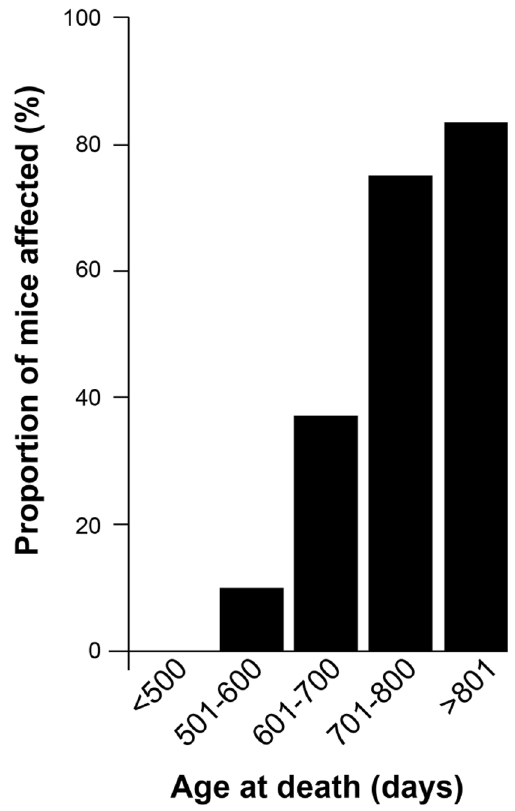
Figure 3. Age dependence of spontaneous neuropathology in Tg20 mice challenged with D-PBS or buffer. The proportion of Tg20 mice affected by neuropathological changes of all types (with patterns A , B and C ) are shown as a percentage of the total number of mice examined in each of the age cohorts indicated on the x-axis. The numbers of mice affected were; < 500 days 0/3, 501–600 days 1/10, 601–700 days 7/18, 701–800 days 12/17 and > 801 days